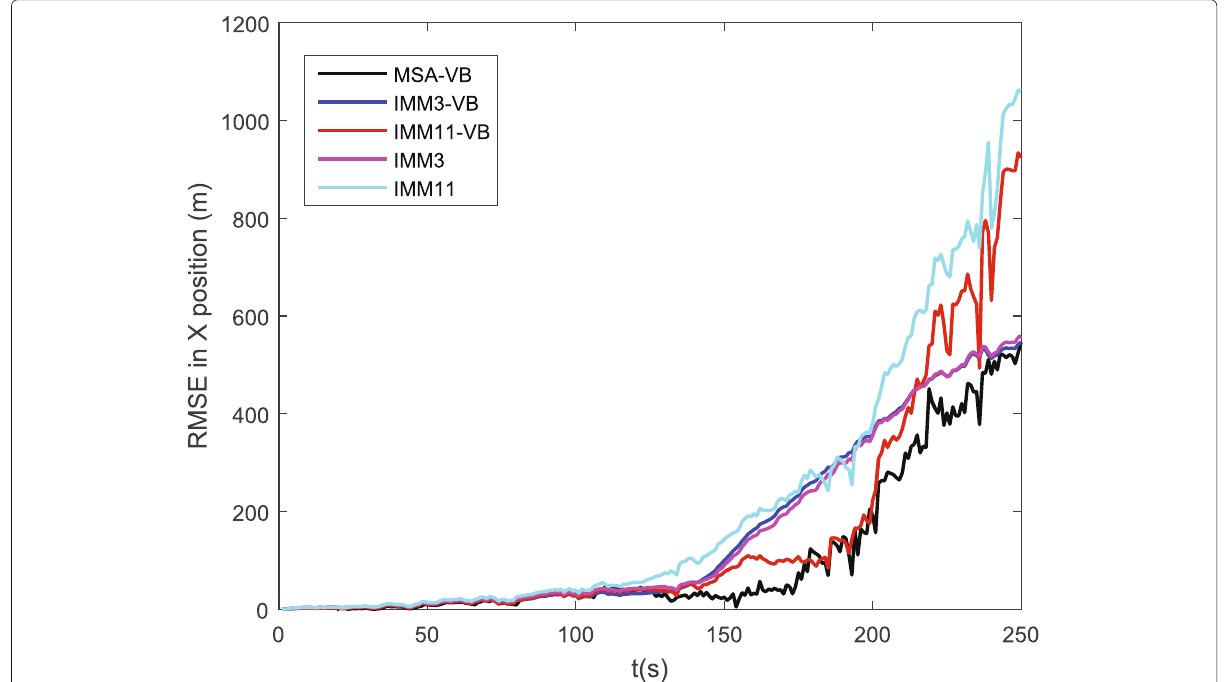
Fig. 6 RMSEs in X position of the proposed algorithm, IMM3, IMM11, IMM3-VB, and IMM11-VB in scenario